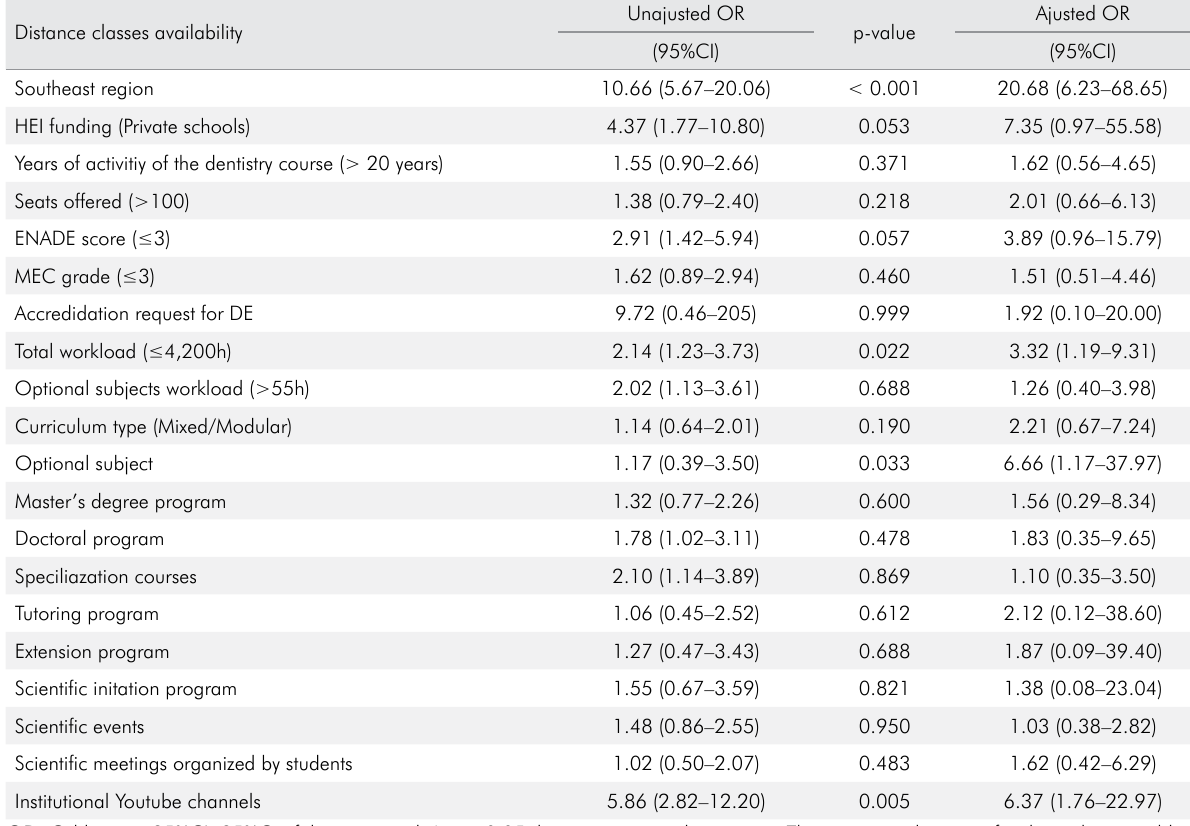
Table 5. Multivariate analysis of factors associated with increased prevalence of dentistry courses in Brazil offering distance classes. Distance classes